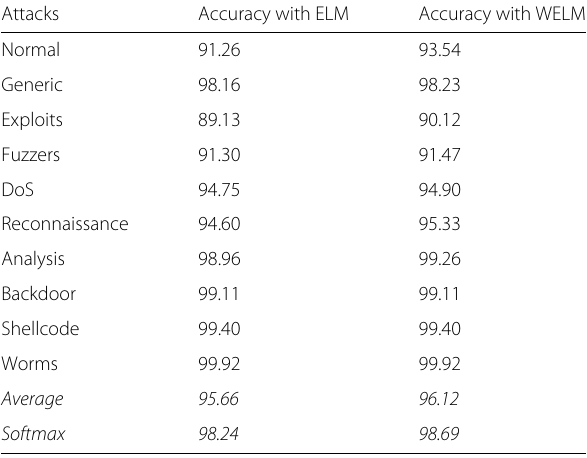
Table 5 Proposed system based on WELM performance on the